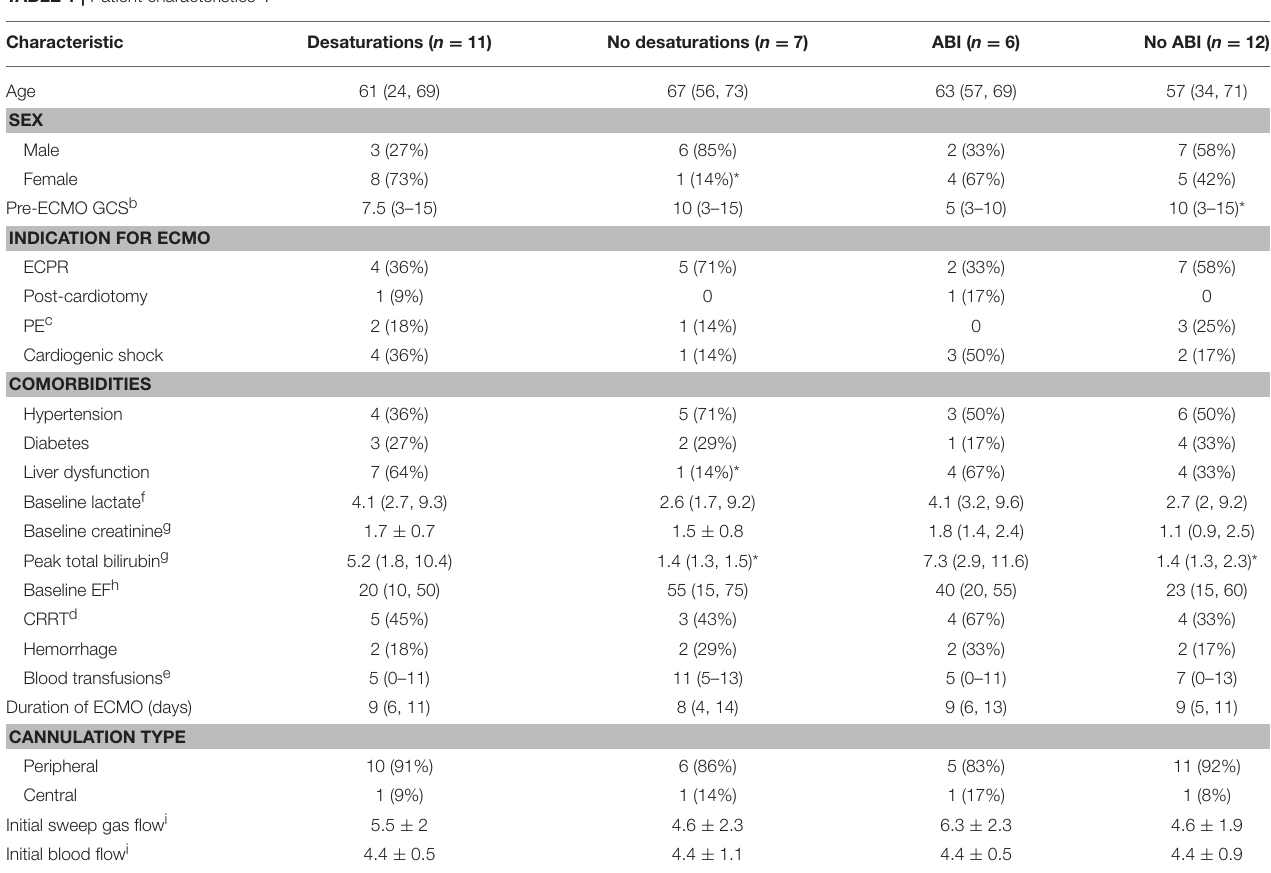
TABLE 1 | Patient characteristics a